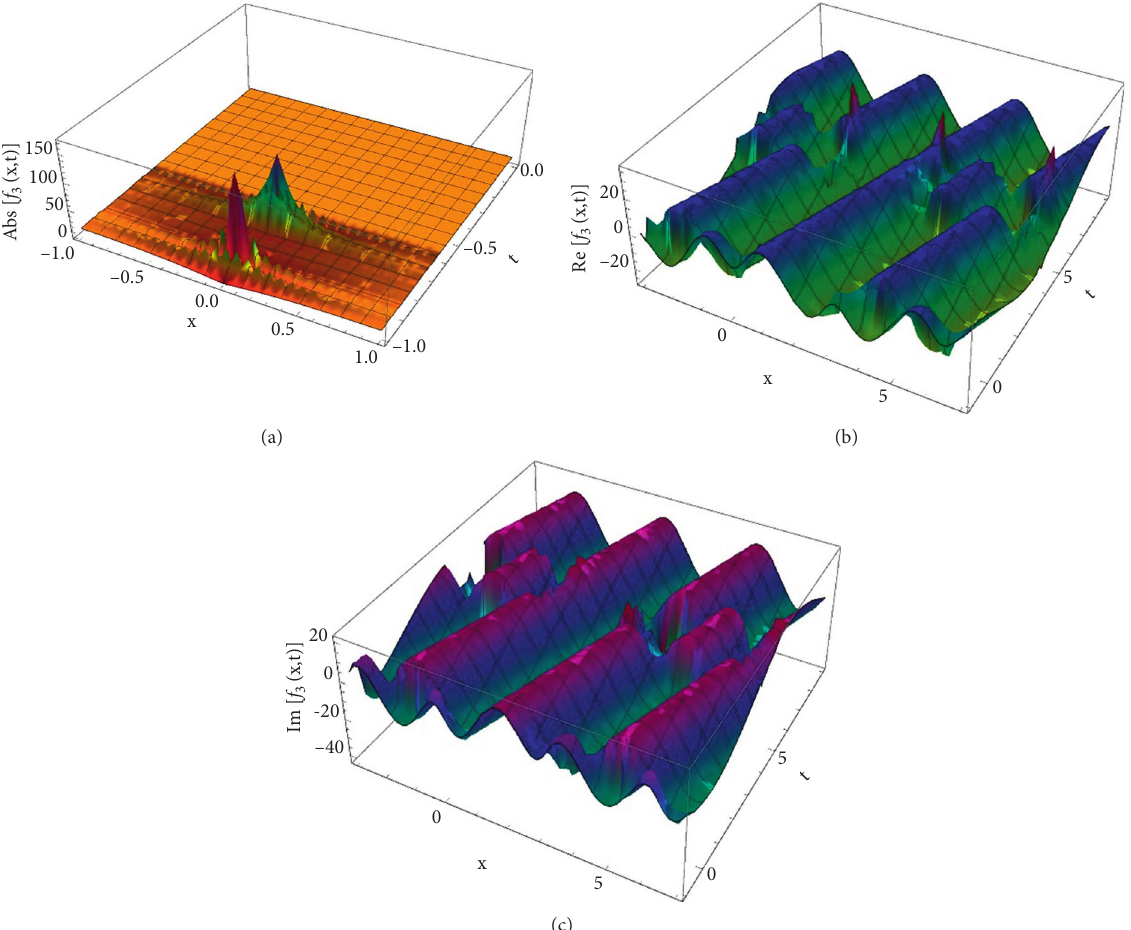
Figure 1: Optical soliton wave solutions of the absolute (a), real (b), and imaginary (c) value of equation (8) in three-dimensional view when � 9, ϑ � 0 . 5, c � − 9, c � 4, and h � ( θ � 1, α � − 1, μ � 4, c 1 2 3